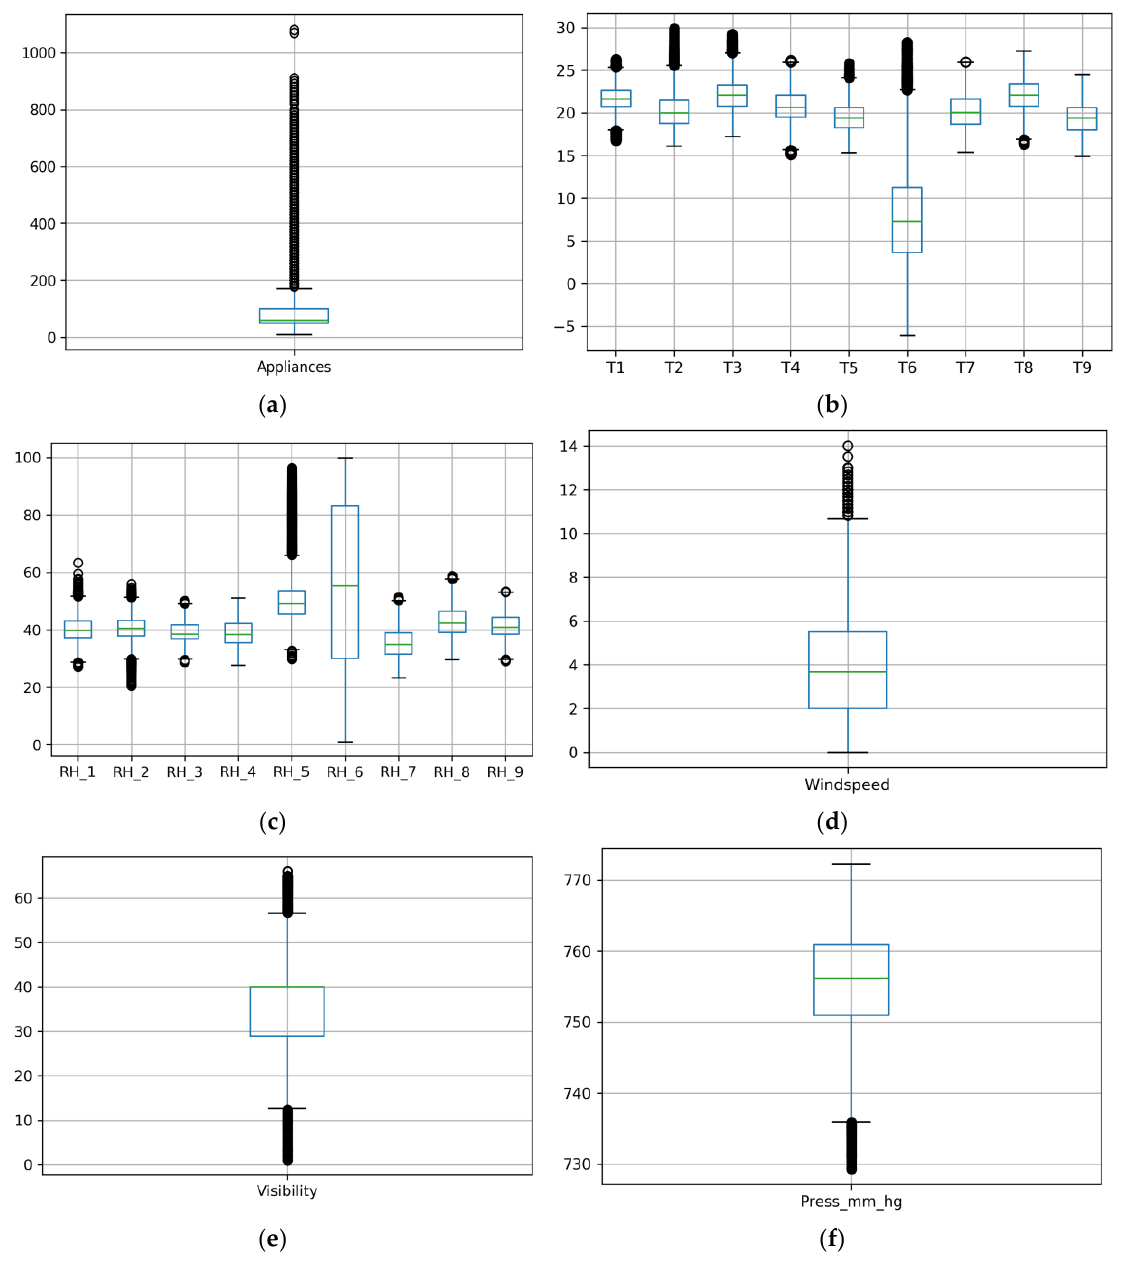
Figure 4. Box plots of dataset features showing the ranges of values for each variable in order to define membership functions. The features used in this fuzzy system case study are: ( a ) Appliance Consumption in Wh; ( b ) Temperature of nine rooms in °C; ( c ) Humidity percentage of nine rooms; ( d ) Wind speed in m/s; ( e ) Visibility in km; ( f ) Pressure in mm Hg. Table 1. Linguistic terms for input and output fuzzy variables.